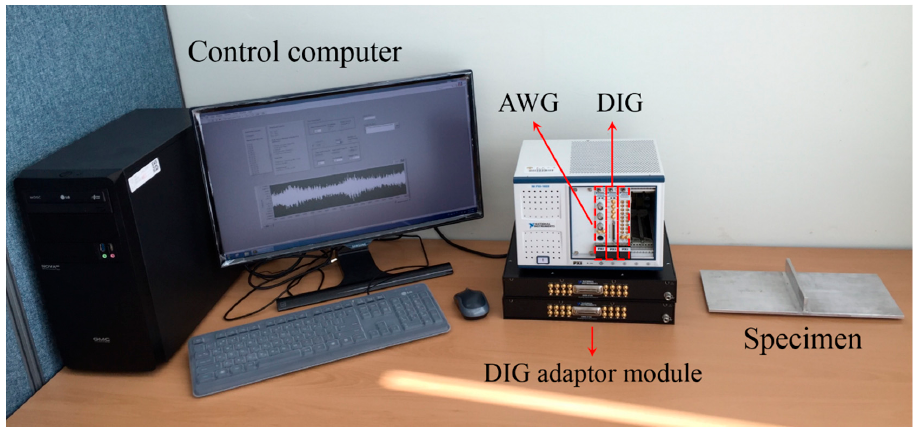
Figure 13 . Experimental setup consisted of a control computer, an arbitrary waveform generator (AWG), a multi-channel digitizer (DIG), DIG adaptor modules and the specimen.